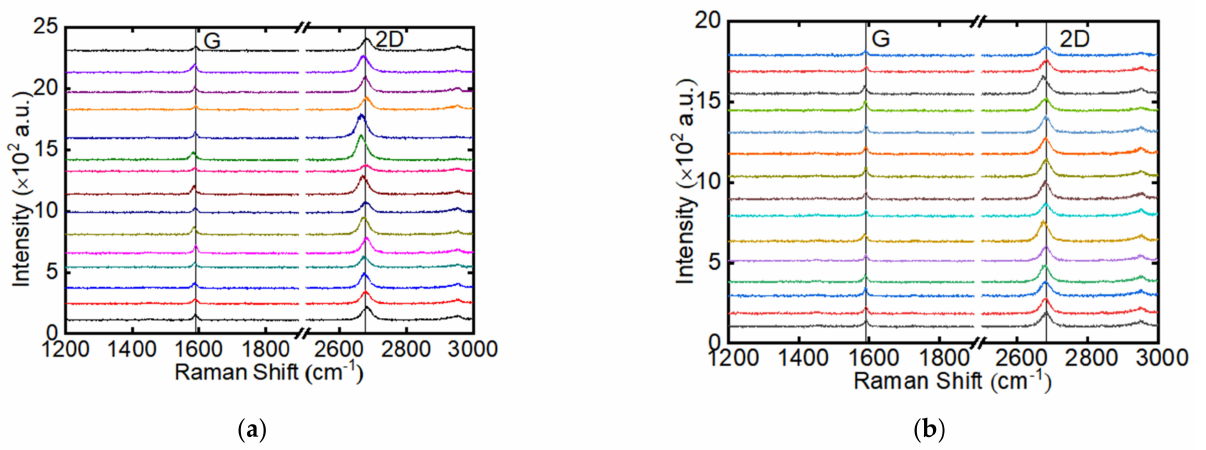
Figure 2. ( a , b ) Raman spectra of as-received